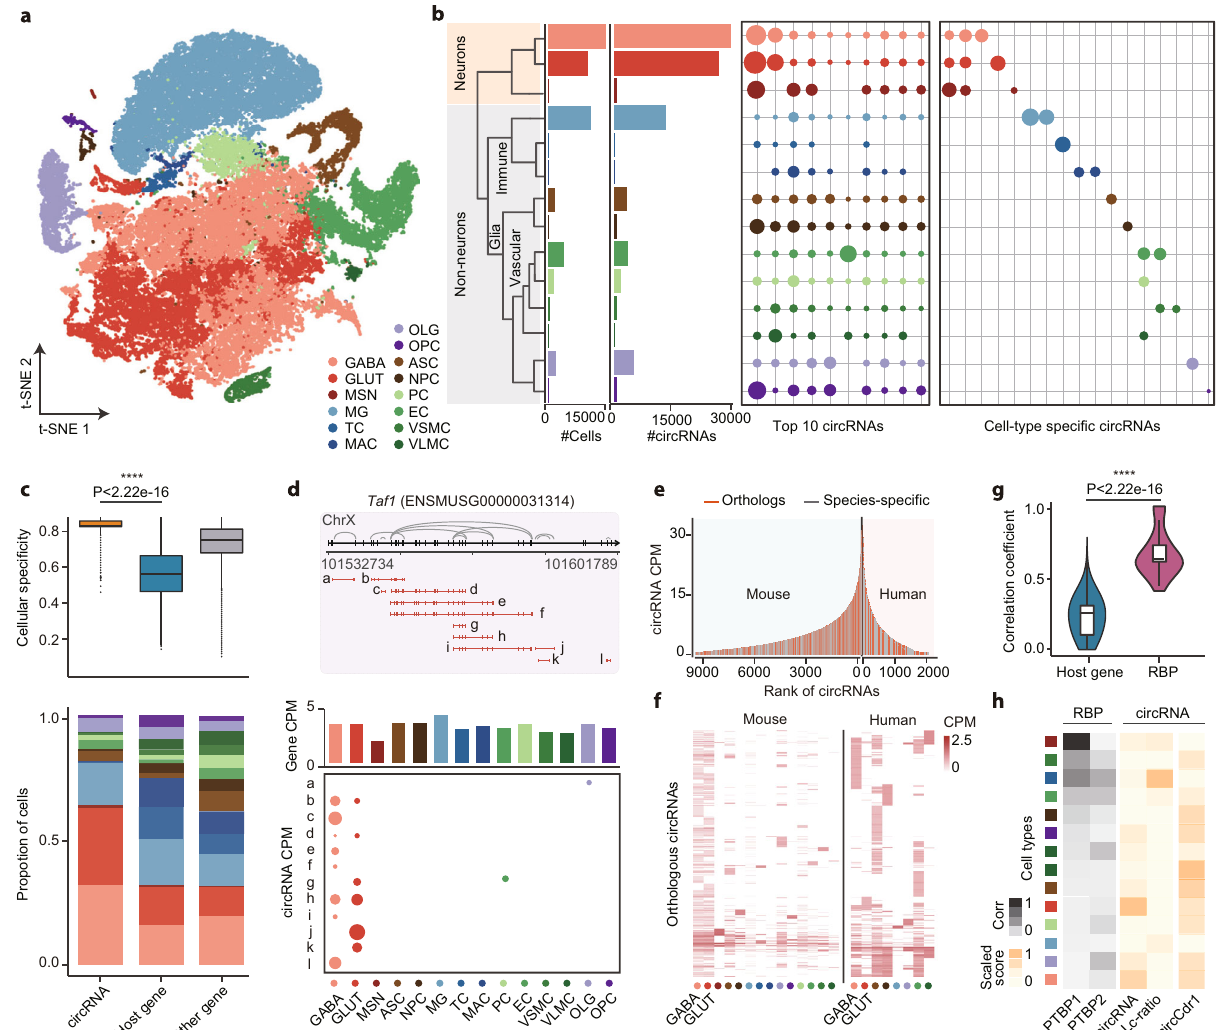
Fig. 2 Enriched expression of circRNAs in inhibitory and excitatory neurons. a The t-SNE plot of all 41,911 brain single cells, colored by annotated cell types. GABA, GABAergic neurons. GLUT, glutamatergic neurons. MG, microglia cells. b Panels from left to right: the number of cells; the number of identi fi ed circRNAs; expression values of top 10 highly expressed circRNAs; expressed values of cell-type-speci fi c circRNAs in each cluster. Sizes of points indicate the mean expression values measured by CPM. c The cellular speci fi city of circRNAs ( n = 74,678), circRNA hosting genes ( n = 13,467), and non- hosting genes ( n = 39,253). Upper, the cell speci fi city was measured by the Tau method. Bottom, the proportion of cell types in all expressing cells. d Example of 12 circRNAs generated from the Taf1 loci. Upper, schematic view of gene structure and back-splicing events (grey lines). Bottom, mean expression levels of circRNA isoforms and Taf1 gene in each cell cluster. e Orthologues between human and mouse circRNAs. All human and circRNAs were ranked according to their expression levels, and the y axis represents the average CPM of circRNAs in all expressing cells. Red, circRNAs that are conservatively expressed in human and mouse. Grey, circRNAs uniquely detected in each species. f Expression heatmap of 1,048 orthologous circRNAs in human and mouse cells. Filled colors represent the mean CPM of circRNAs in each cluster. g The Spearman correlation between circRNAs and host genes ( n = 13,467) or RBPs ( n = 2995). h Cell-type-speci fi c expression of RBPs and circRNAs. Filled colors indicate the normalized value of gene or circRNA expression values in each cell type. All center lines in the box plots and violin plots indicate the median values, and box limits indicate the upper and lower quartiles of plotted values. The upper and lower whiskers indicate the largest and smallest values within the range of 1.5x IQR from the box limits. *** P < 0.001, Wilcoxon rank-sum test (two-sided). Source data are provided as a Source Data fi blastomeres (TB), fi rst lineage (TE/ICM), second lineage (EPI/